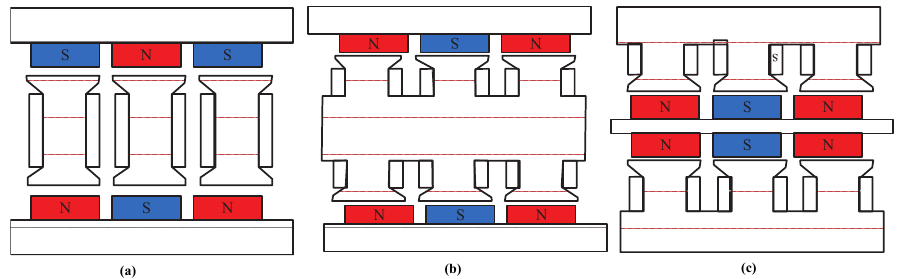
Figure 1. Different topologies of the axial flux permanent magnet synchronous machines (AFPMSMs) ( a ) YASA (yokeless and segmented armature); ( b ) TORUS (toroidally wound internal stator); ( c ) AFIR (axial flux internal rotor)